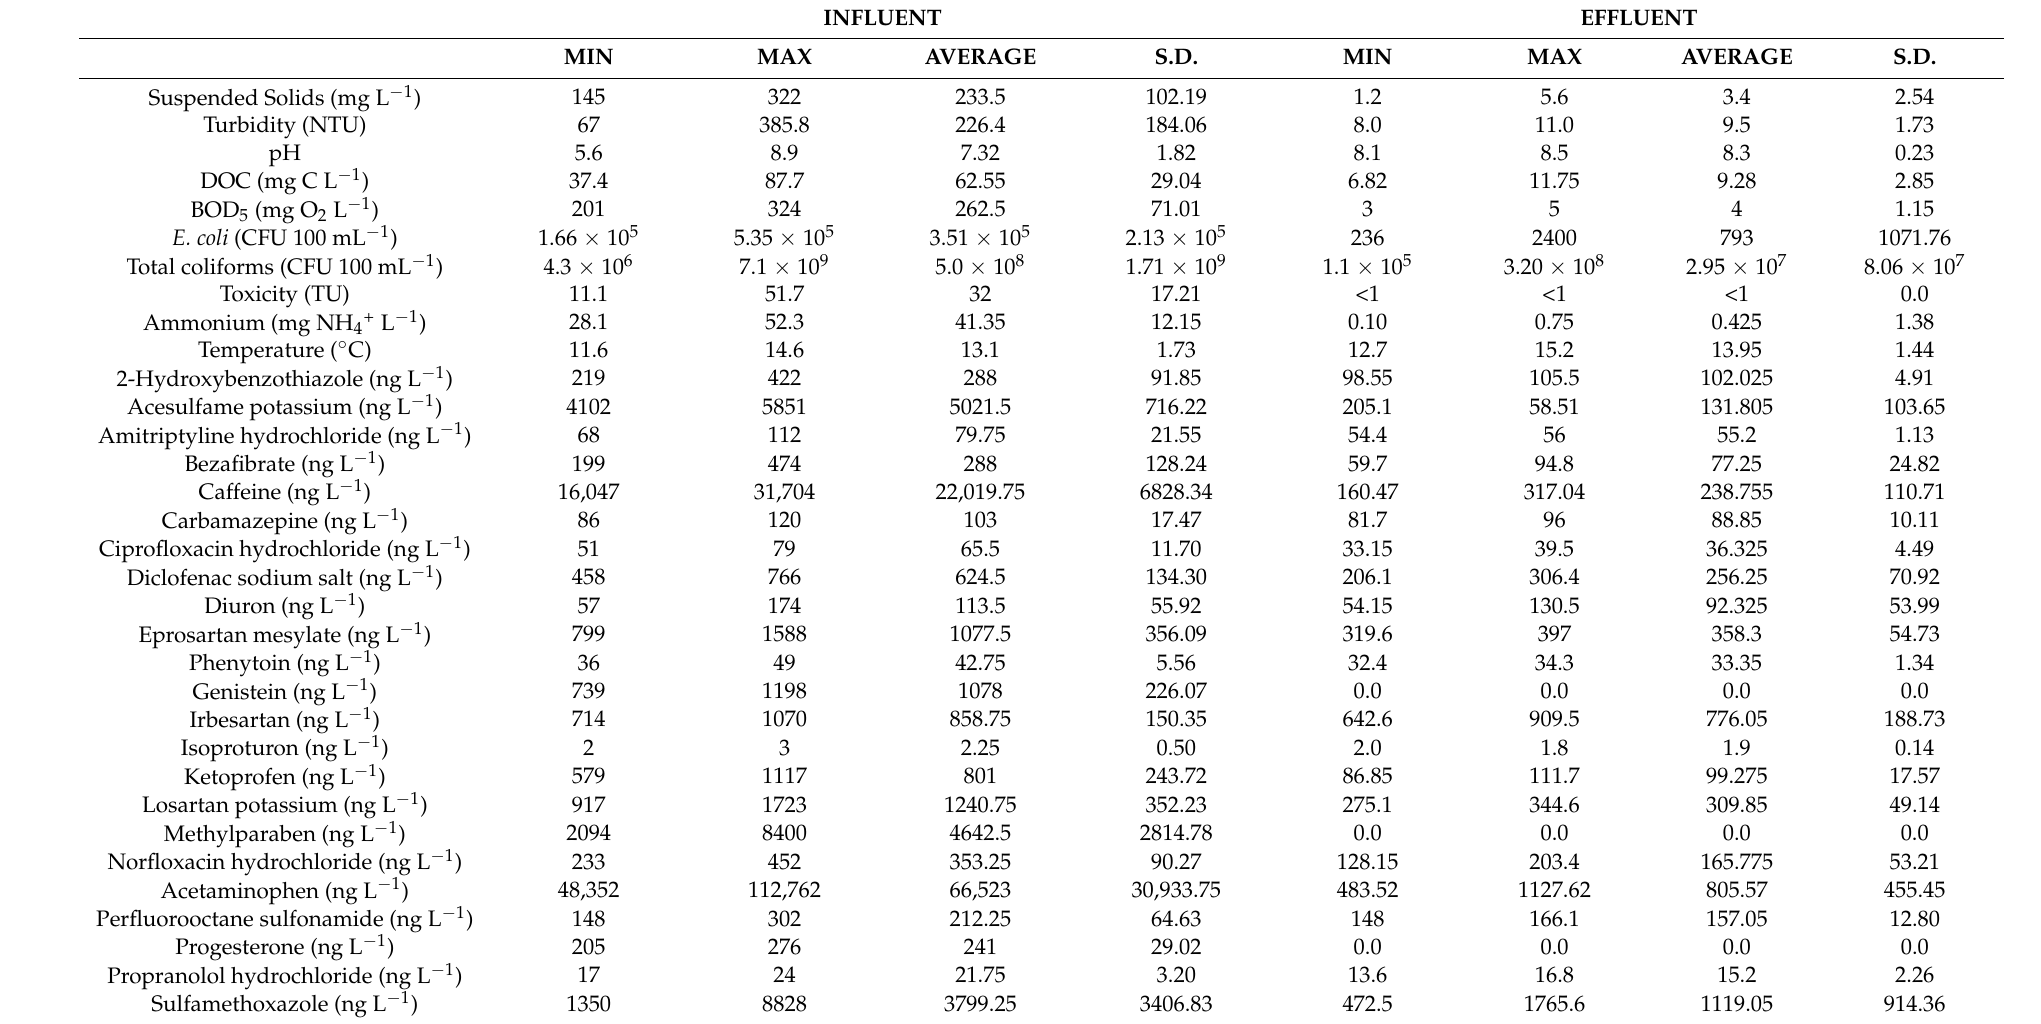
Table 3. Physicochemical characterization of the treated wastewater at Galindo WWTP (May